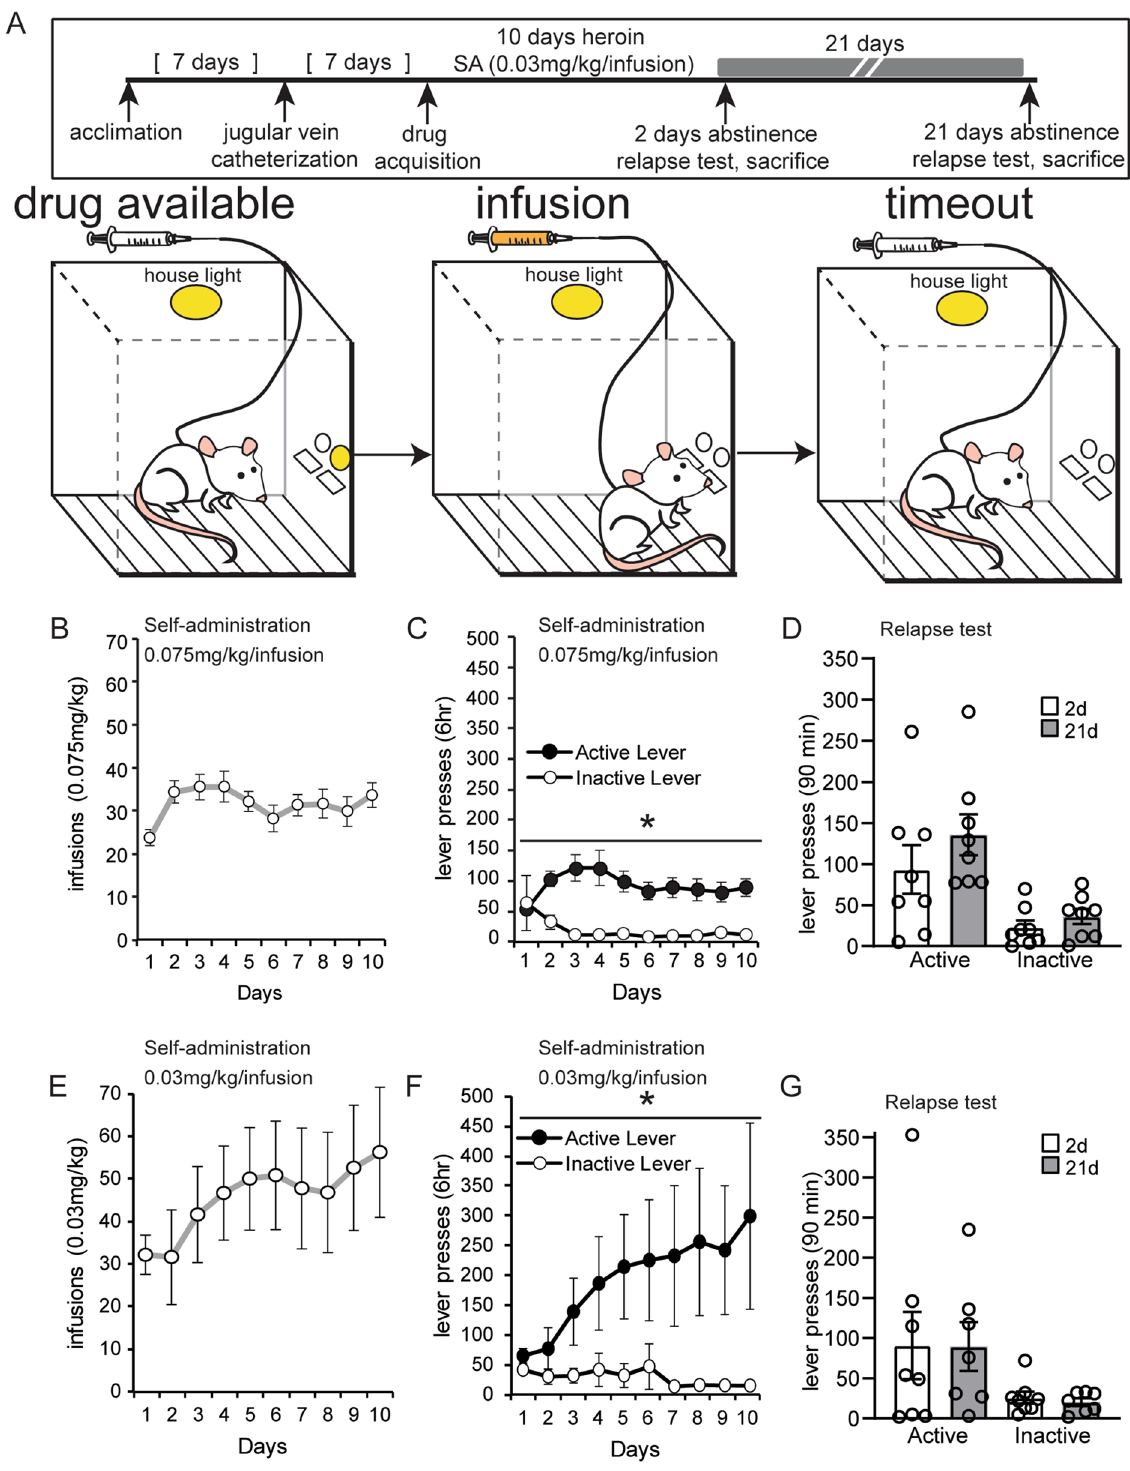
Figure 2. Discriminative cues produce steady drug-seeking during abstinence. ( A ) An overview of the protocol to measure drug seeking after abstinence from heroin self-administration using discriminative drug cues. Animals underwent an identical experimental protocol as described in Experiment 1 except with modified light and tone cues. ( B , C , E , F ) The number of infusions and lever presses during heroin self-administration at a 0.075 mg/kg/infusion dosage ( B , C ) and a lower 0.03 mg/kg/infusion dosage ( E , F ). ( D , G ) Lever pressing during the relapse test after forced abstinence from the 0.075 mg/kg/infusion dosage ( D ) and the 0.03 mg/kg/ infusion dosage ( G ). Error ± SEM. * p <